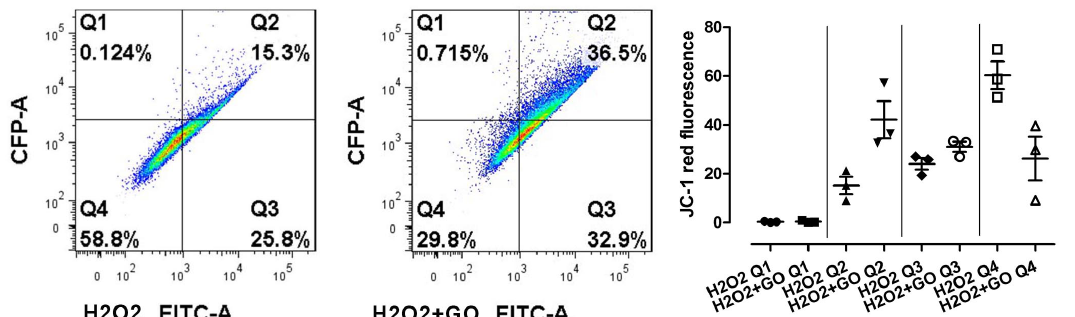
Figure 5. Qualitative flow cytometry assay for mitochondrial depolarization. Data are expressed as mean ± standard error ( n = 3). Statistical analysis was performed using the one-way ANOVA ( p < 0.05). H 2 O 2 denotes cells without GO treatment, exposed to H 2 O 2 ; H 2 O 2 +GO denotes cells treated with GO and exposed to H 2 O 2. ; Q1 population: % of aggregates; Q2 population: % of monomers + aggregates; Q3 population: % of monomers; Q4 population: % of monomers ( − )/aggregates ( −